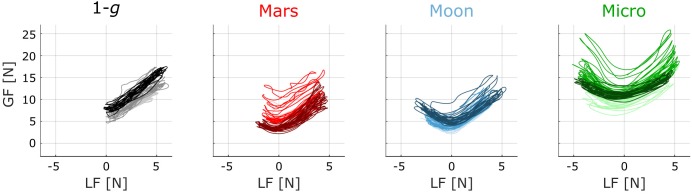
Traces of GF versus LF for a typical subject within each condition. Lighter traces correspond to the first block, medium traces to the third block, and darker traces to the last block of the condition. Only the 15 first cycles are plotted. In the 1-g condition, the blocks plotted are the first, third, and fourth blocks performed on board the aircraft before the first parabola.